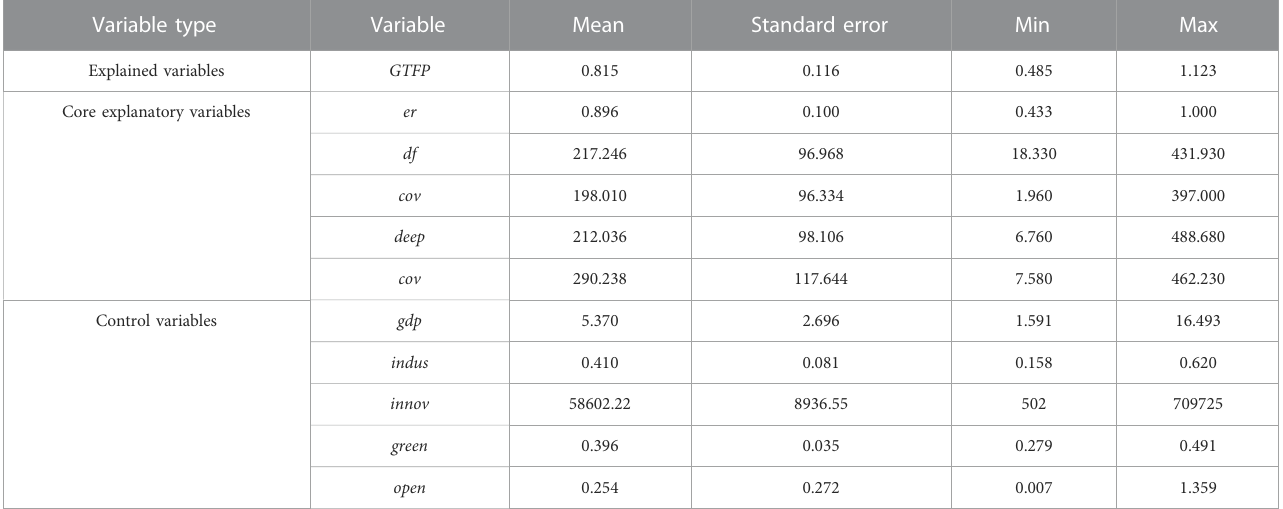
TABLE 1 Descriptive statistics of variables. Variable